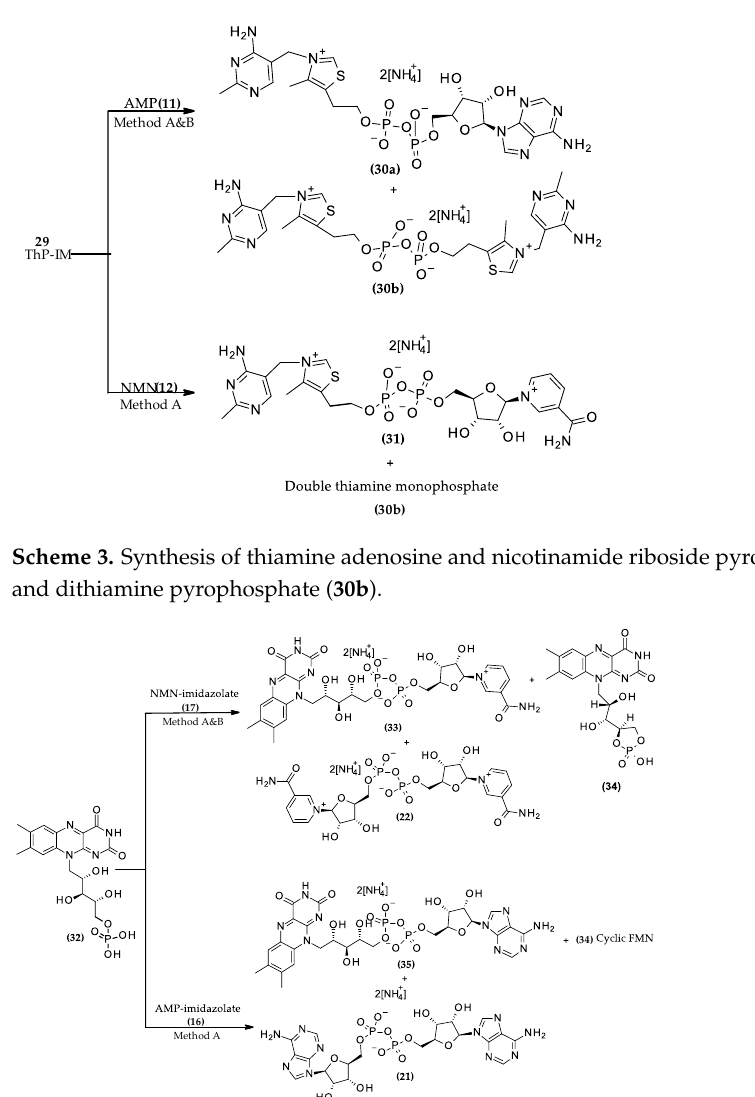
Method A Scheme 5. Synthesis of thiamine adenosine triphosphate ( 37 ). 2.3. Synthesis of Labeled NAD ( 25 ) Recent efforts towards understanding how the vitamin B3 derived cofactors are transported across membranes based on mass spectrometry enabled isotopic tracing metabolomics has required the synthesis of stable isotopically labeled NAD ( 25 ) [2] . Such species informed on whether NAD was transported intact or was first metabo- lized to a non-phosphorylated species prior to transport from one organelle to another [2,42]. In the latter case, a NAD isotopologue possessing heavy atoms on either side of